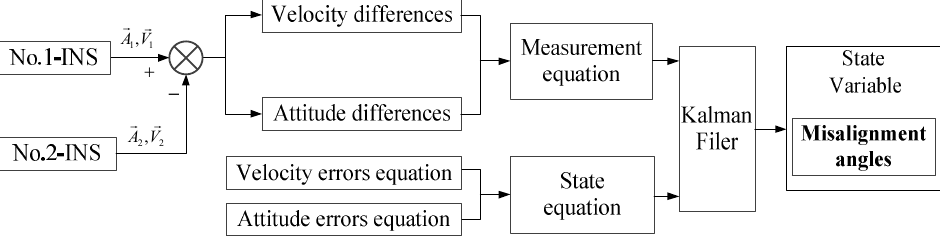
Figure 4. Design of Kalman filter.